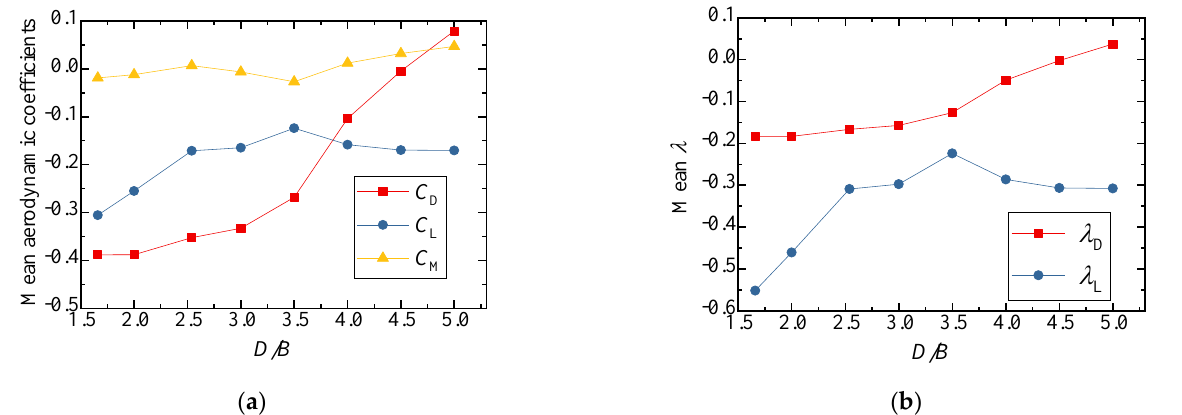
Figure 22. Comparison results for Case 4: ( a ) Aerodynamic coefficients of the downstream vehicle; ( b ) Interference factor of the downstream vehicle.